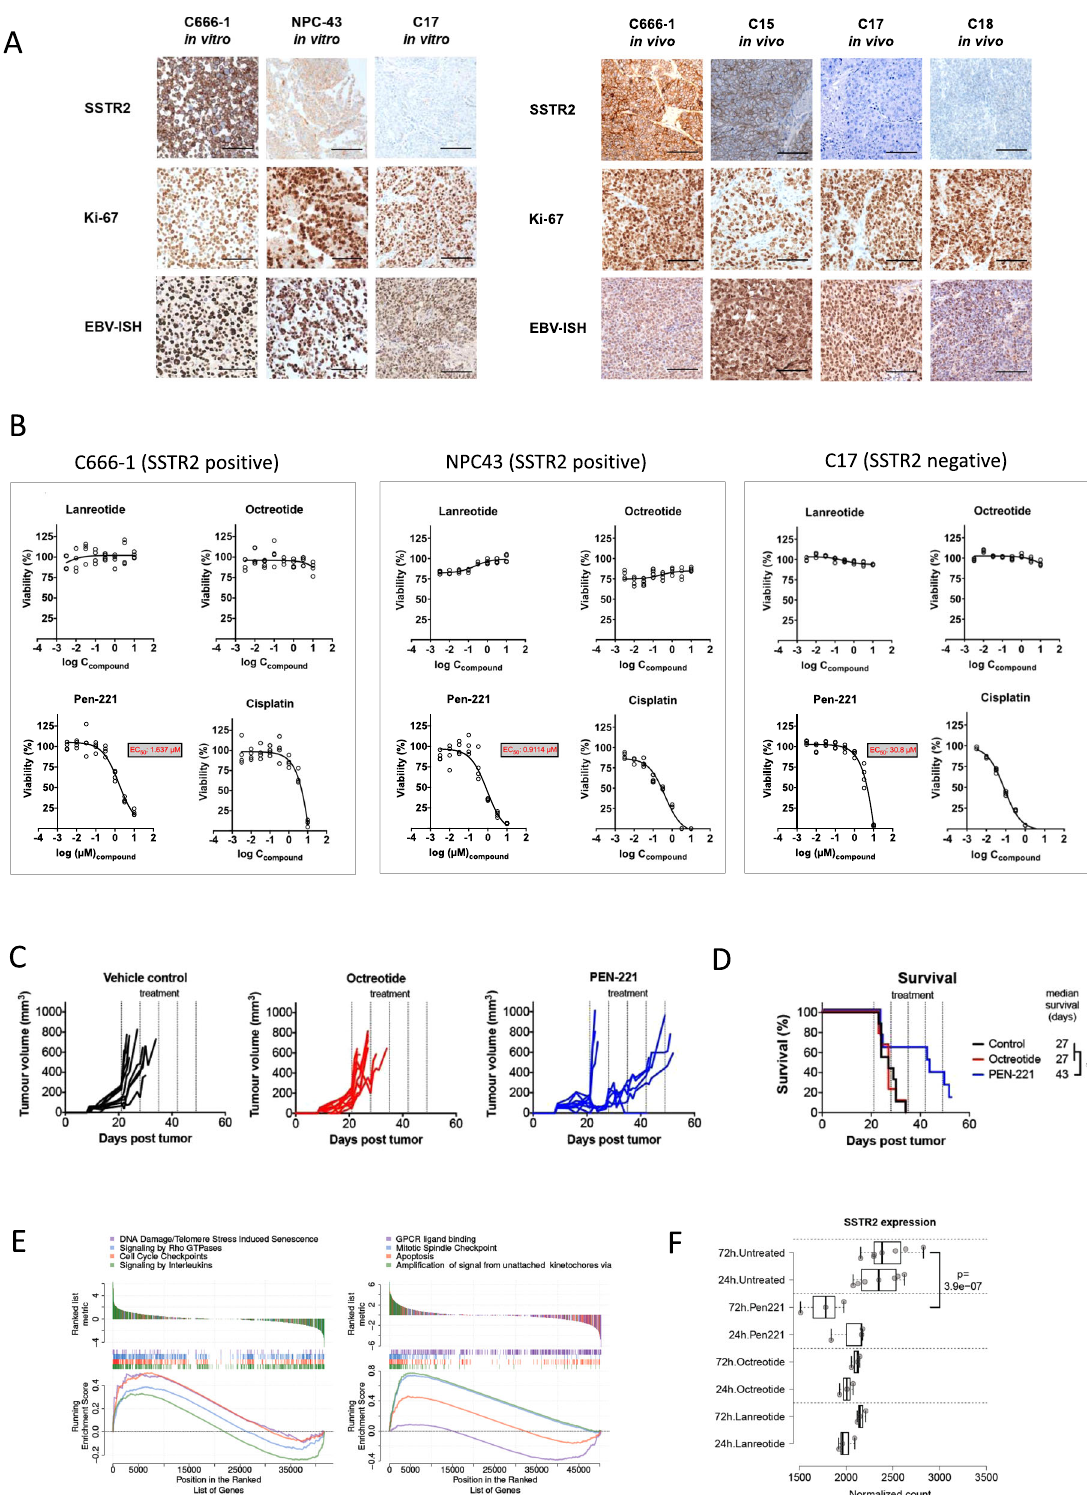
Methods Materials . Four hundred and two formalin- fi xed paraf fi n-embedded (FFPE) NPC specimens were obtained from three European institutions